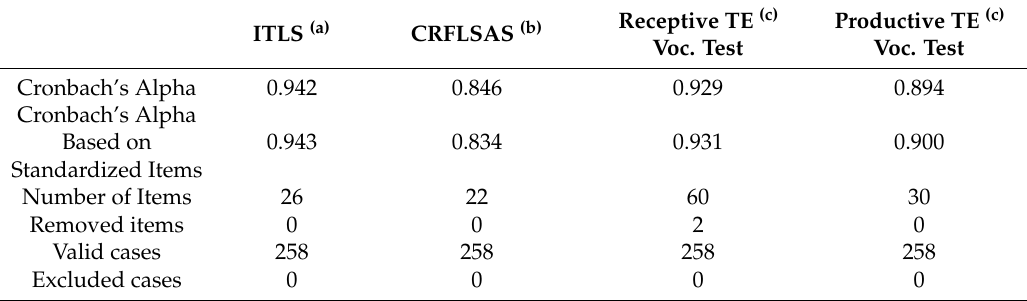
Table 3. Reliability of research instruments during the